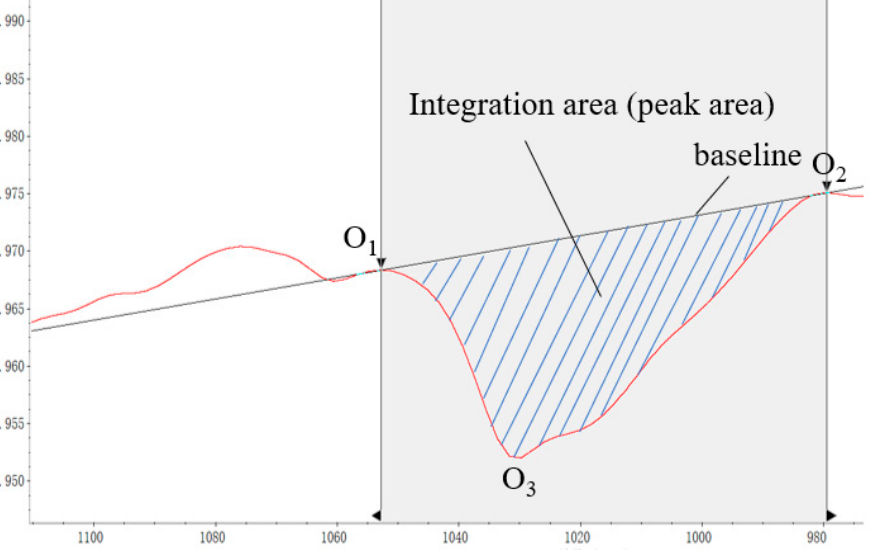
Figure 2. Peak area calculation diagram.